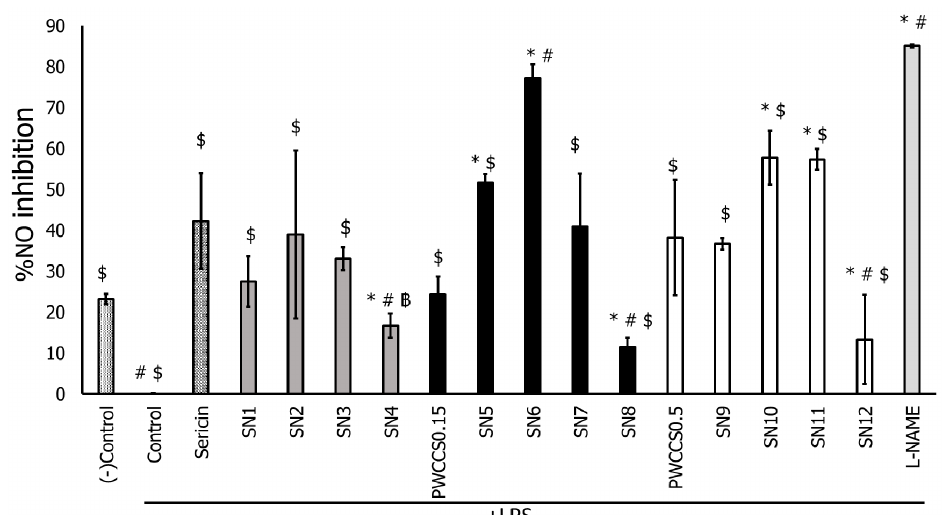
Figure 3. Effects of sericin, sericin-hydrogel formulations (SN1-SN12), L-NAME 200 μ M, purple waxy corn cob extract solution 0.15% (PWCCS0.15), and 0.50% (PWCCS0.5) on nitric oxide production by LPS-stimulated RAW 264.7 cells. Data represent the mean ± SEM of three replicates. Statistical significance was evaluated by Dunnett post-hoc test, * p < 0.05 compared with ( − )control, # p < 0.05 compared with SN2, ฿ p < 0.05 compared with sericin, $ p < 0.05 compared with L-NAME 200 µ M.